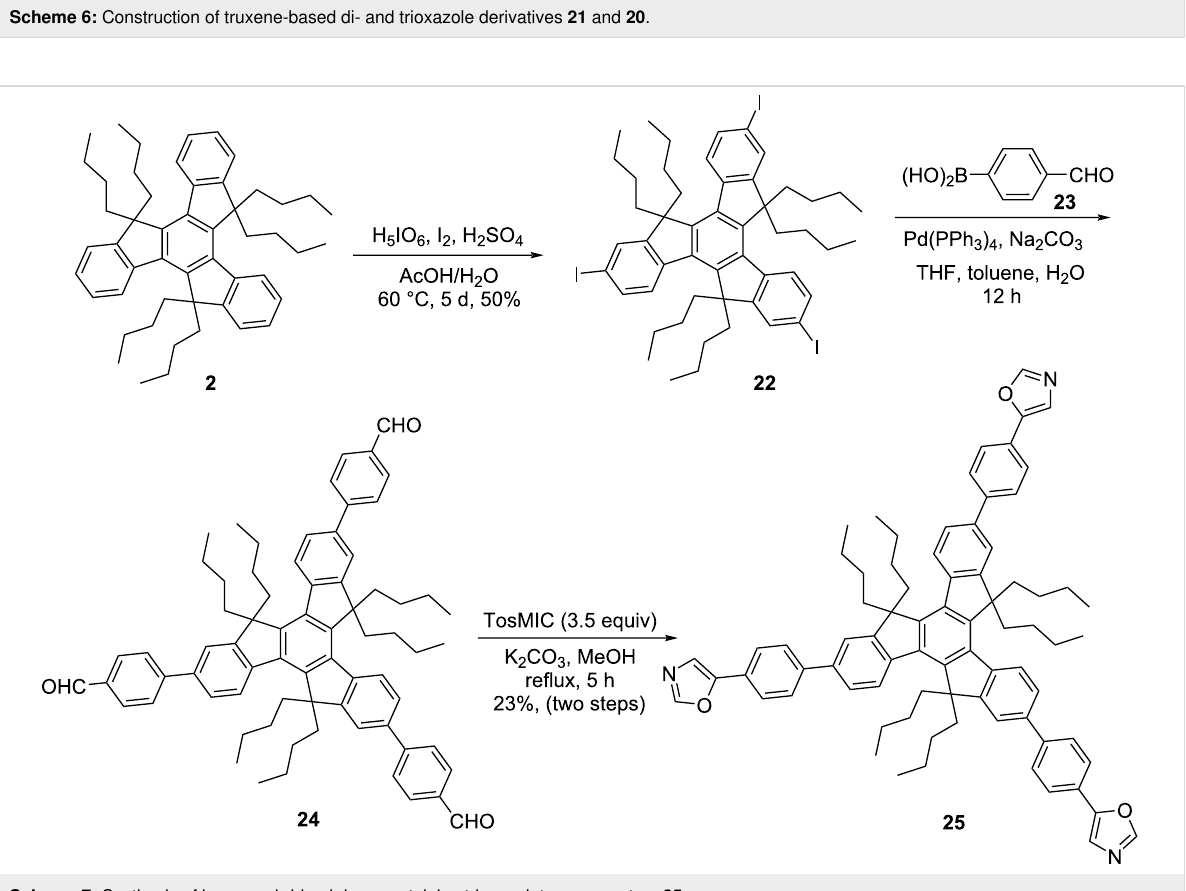
Scheme 7: Synthesis of benzene-bridged rings containing trioxazolotruxene system 25